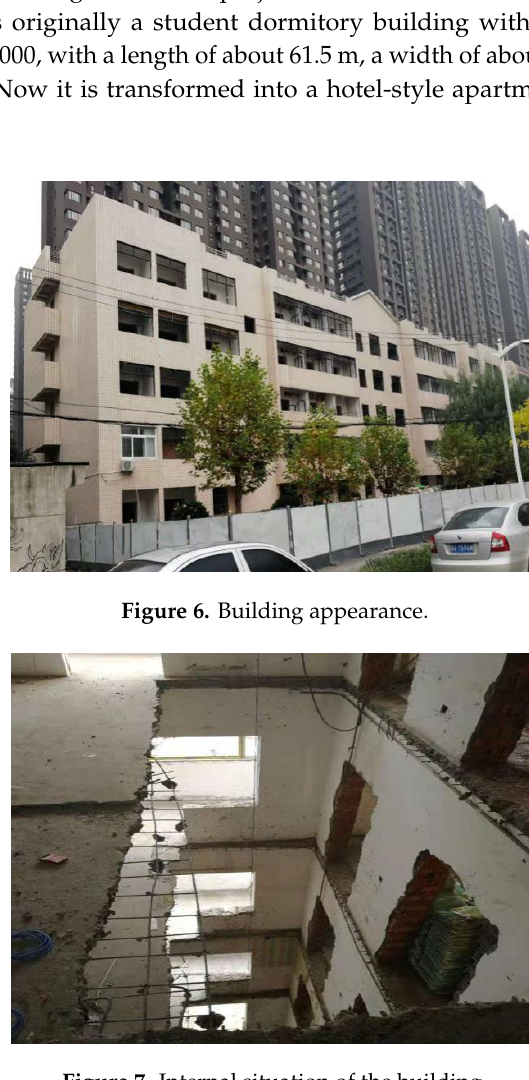
Figure 7. Internal situation of the building.